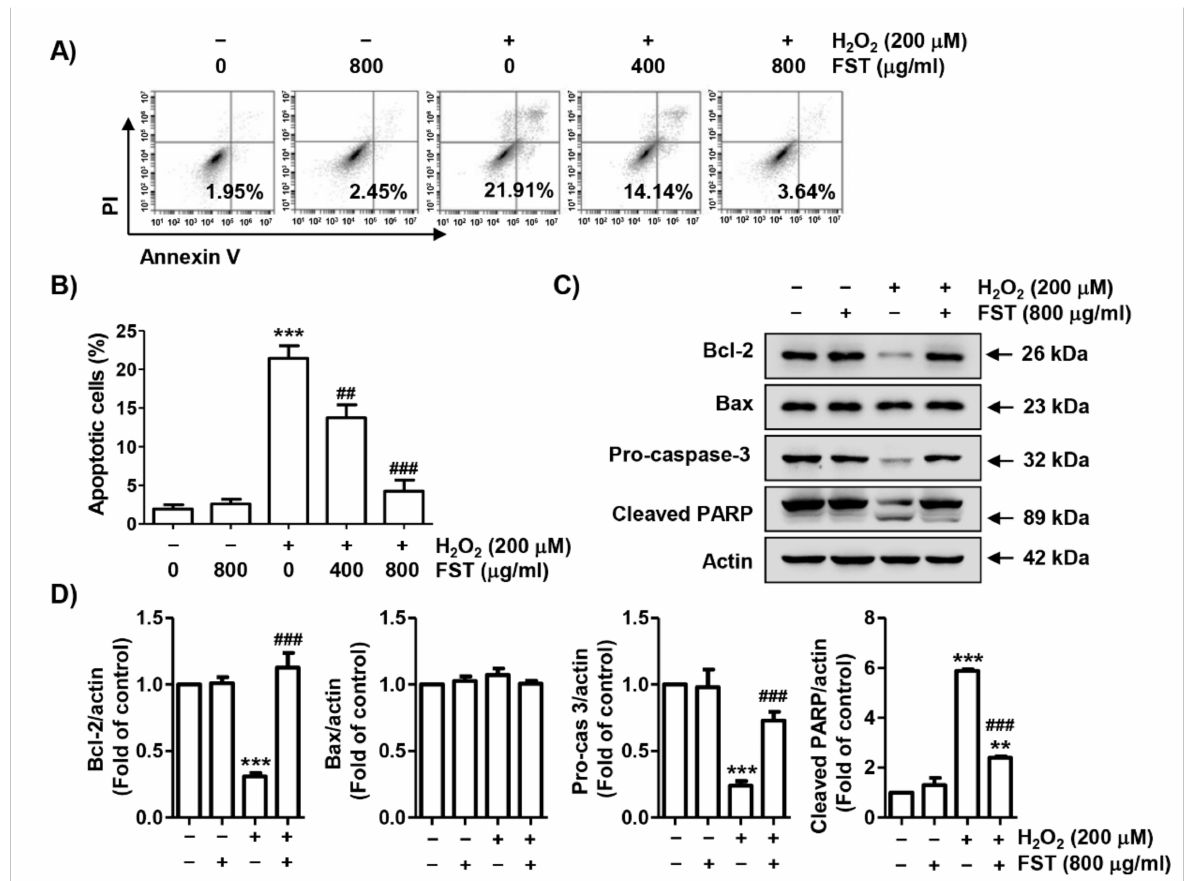
Figure 4. Protective effect of FST on apoptosis in H 2 O 2 -stimulated MC3T3-E1 cells. Cells were pre-treated with or without FST (800 µ g/mL) and exposure to H 2 O 2 (200 µ M) for 24 h. ( A , B ) Cells were stained with annexin V and propidium iodide (PI) and then analyzed by flow cytometry. ( A ) Percentages of apoptotic cells are shown as annexin V-positive cells. ( B ) Quantitative analysis of apoptotic cells in percentage. *** p < 0.001 vs. control cells. ## p < 0.01 and ### p < 0.001 vs. H 2 O 2 -treated cells. ( C ) The expression of apoptosis regulators. Actin was used for loading control. ( D ) Relative band density of apoptosis regulators. ** p < 0.01 and *** p < 0.001 vs. control cells. ### p < 0.001 vs. H 2 O 2 -treated